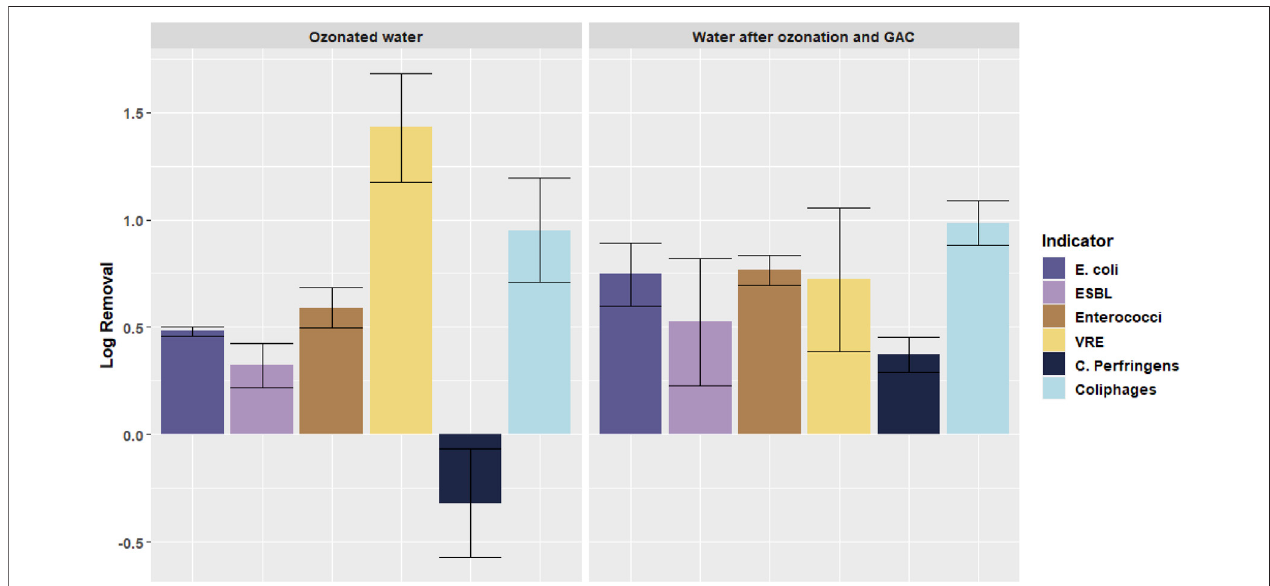
FIGURE 5 | Log removal of different microorganisms in the pilot plant after different treatment steps: ozonated water after ozonation (location B) and water after ozonoation and GAC fi ltration (location C). Error bars indicate standard deviation.